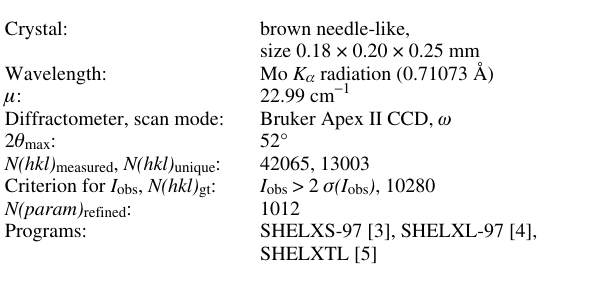
Table 1. Data collection and handling.